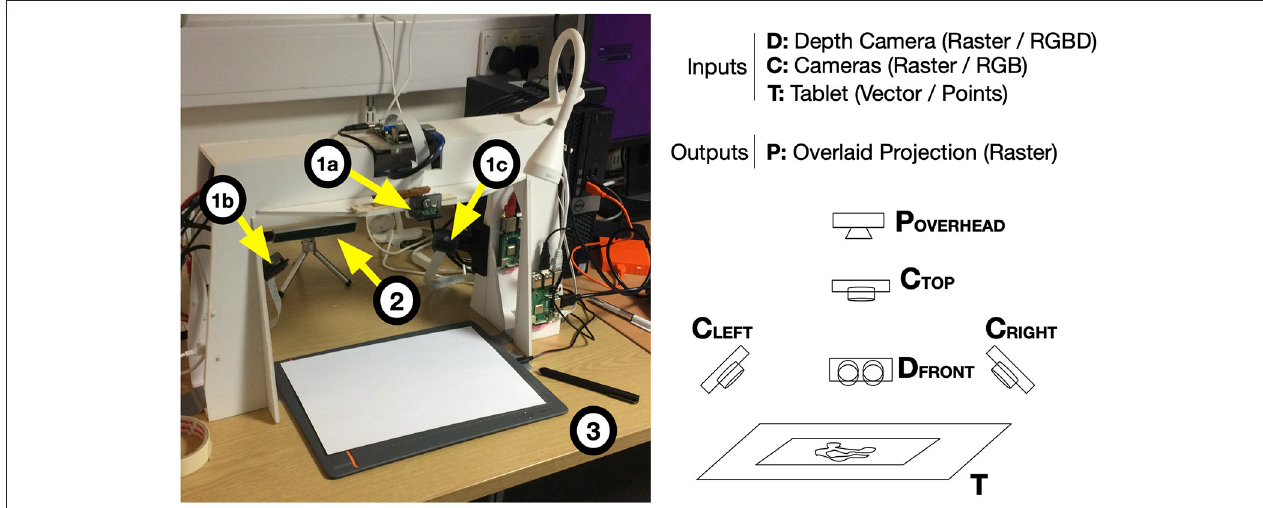
( D FRONT ), and a WACOM Bamboo Slate 10 digital “sketchpad” ( T ), which uses a pressure sensitive pen that tracks movement and produces marks on physical paper. The cameras observe the drawing area from multiple angles and record textural aspects of the drawing, while the digital sketchpad records a vector representation of the pen’s